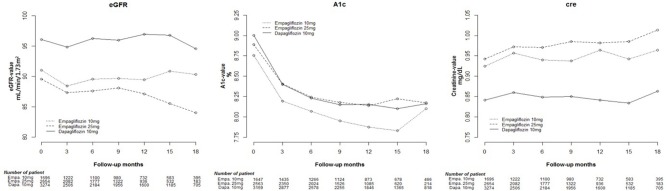
Change in estimated glomerular filtration rate (eGFR), and glycated hemoglobin (HbA1c), and creatinine (Cre) levels in empagliflozin 10 mg/tab, empagliflozin 25 mg/tab, and dapagliflozin 10 mg/tab users.